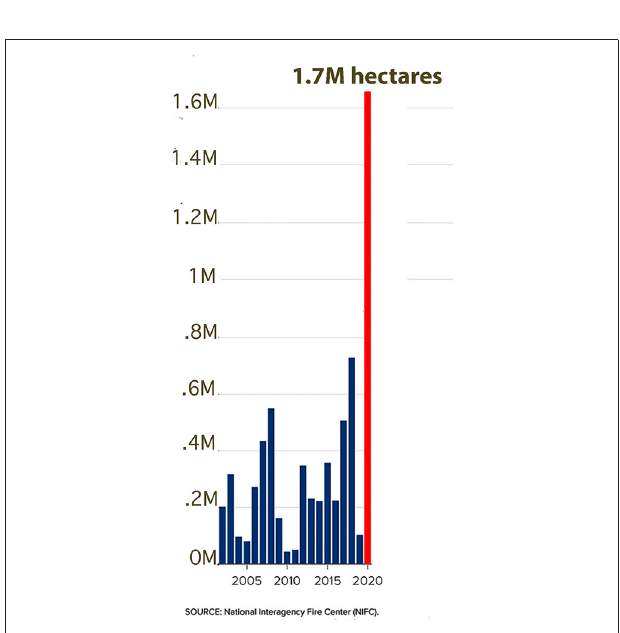
FIGURE 2 | Hectares burned by wildfire in California (National Interagency Fire Center,